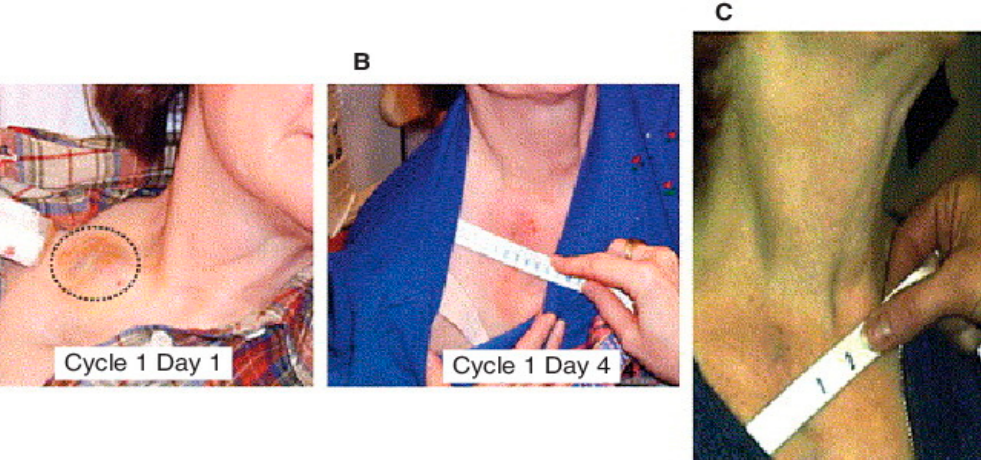
Figure 7. Objective clinical response to INGN 241 (Ad.5- mda-7 ) in cohort 8 patient with metastatic melanoma (patient 83). Injected lesion was on right clavicle (dashed circle in ( A )). ( B ) by day 4, the region is inflamed. ( C ) At the end of cycle 1 (day 30), the lesion has completely regressed. This patient was alive > 600 days post INGN 241 treatment. Reprinted by permission from Lebedeva et al. 2007 [65].